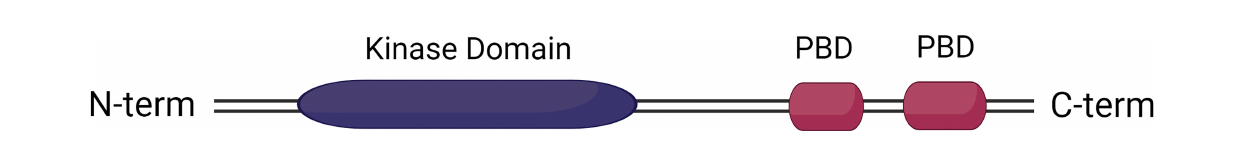
FIGURE 1 | PLK1 protein domains. PLK1 structure includes two functional polo-box domains (PBDs) at C-terminal and the kinase domain at